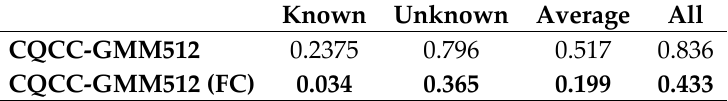
Table 1. Comparison of spoofing detection performance (in terms of equal error rates (EER)) of Gaussian mixture model (GMM)-based systems when diagonal covariance and full covariance GMMs are used. The best results are highlighted in bold face.